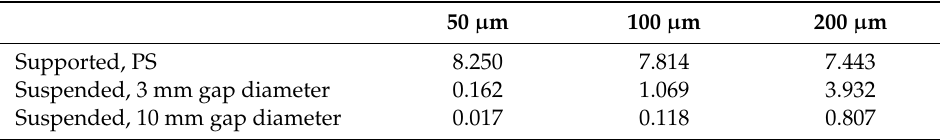
Table 1. Indentation modulus (MPa) for electrospun fiber mat constructs.